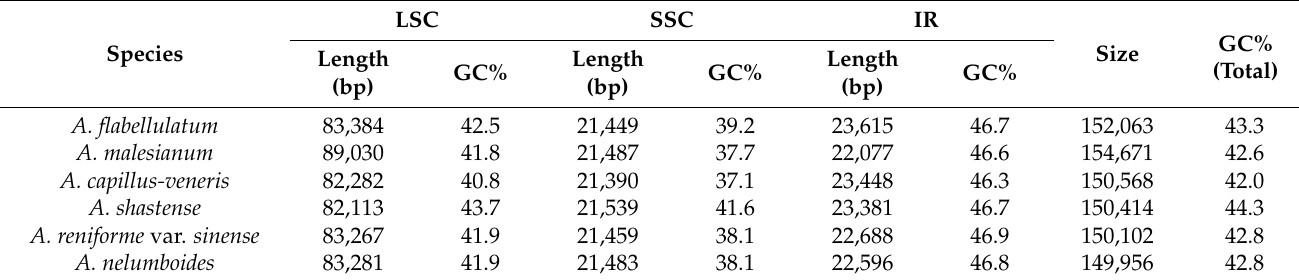
Table 1. General comparison of six Adiantum cp genomes.